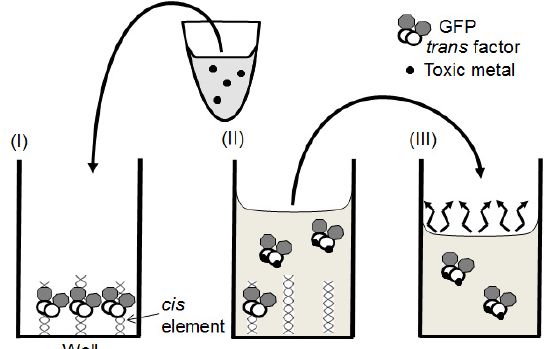
Figure 2. Expected association/dissociation statuses between GFP-tagged trans factor and cis element or metal. A sample mixture is loaded into (I), a well in which a